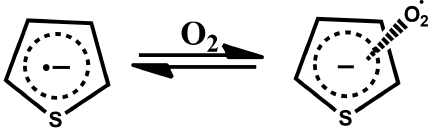
Figure 11. Thiophene–oxygen charge-transfer complex, analogous to the charge-transfer complex discovered for non-doped polythiophenes